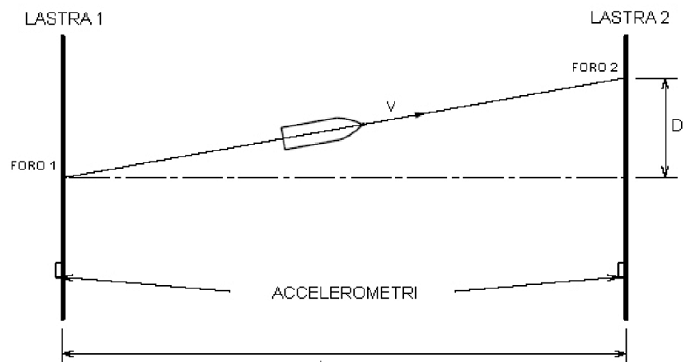
Figura 6: Traiettoria del proiettile deviato dall’impatto: il proiettile percorre uno spazio maggiore della distanza fra le lastre; la distanza D determina un ritardo nell’acquisizione del secondo segnale.